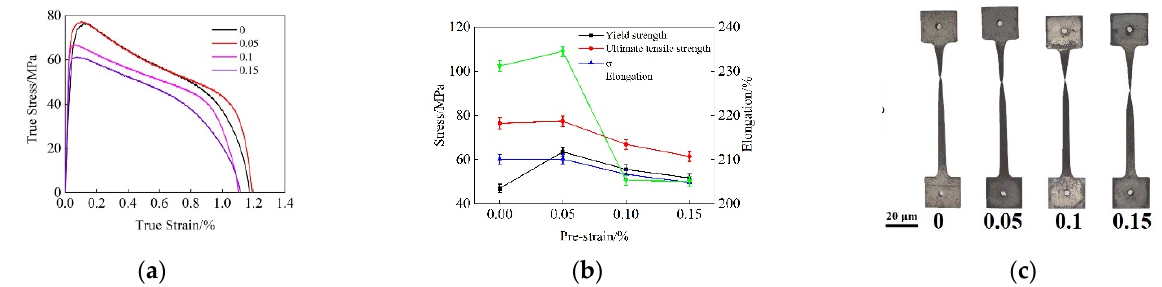
Figure 3. Hot tensile behavior of different Ti ‐ 6Al ‐ 4V specimens stretched at 850 °C with 0.001 s − 1 : ( a ) True stress ‐ strain curves; ( b ) Tensile properties; ( c ) Tested samples with different pre ‐ strain.